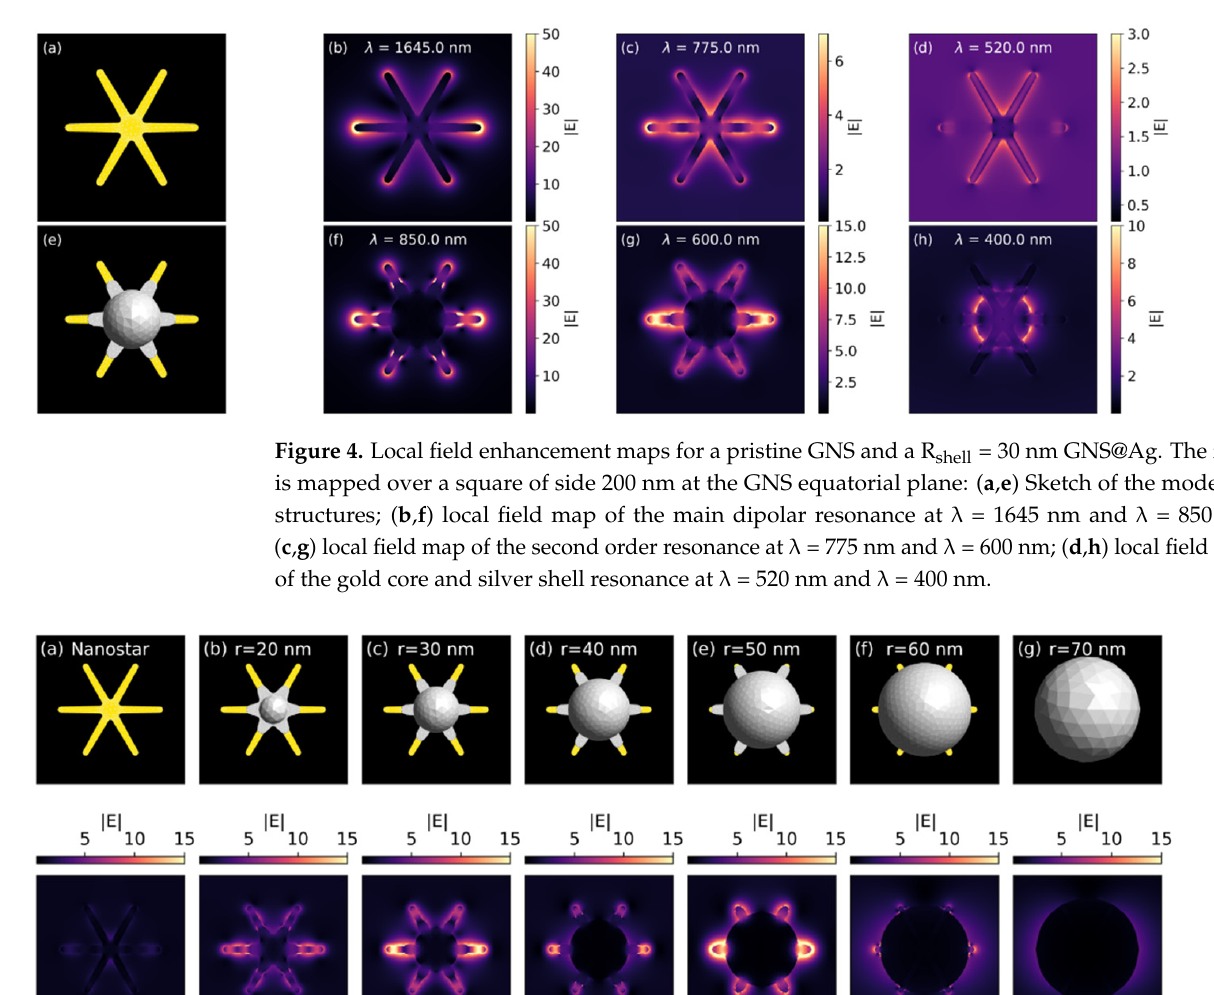
Figure 5. Local field enhancement maps for all the modelled structures at λ = 608 nm. ( a ): naked GNS; ( b – f ): GNS with increasing Ag shell thickness; ( g ) GNS completely enclosed by Ag shell of 70 nm thickness. The field is mapped over a square of side 200 nm at the nanostar equatorial plane.